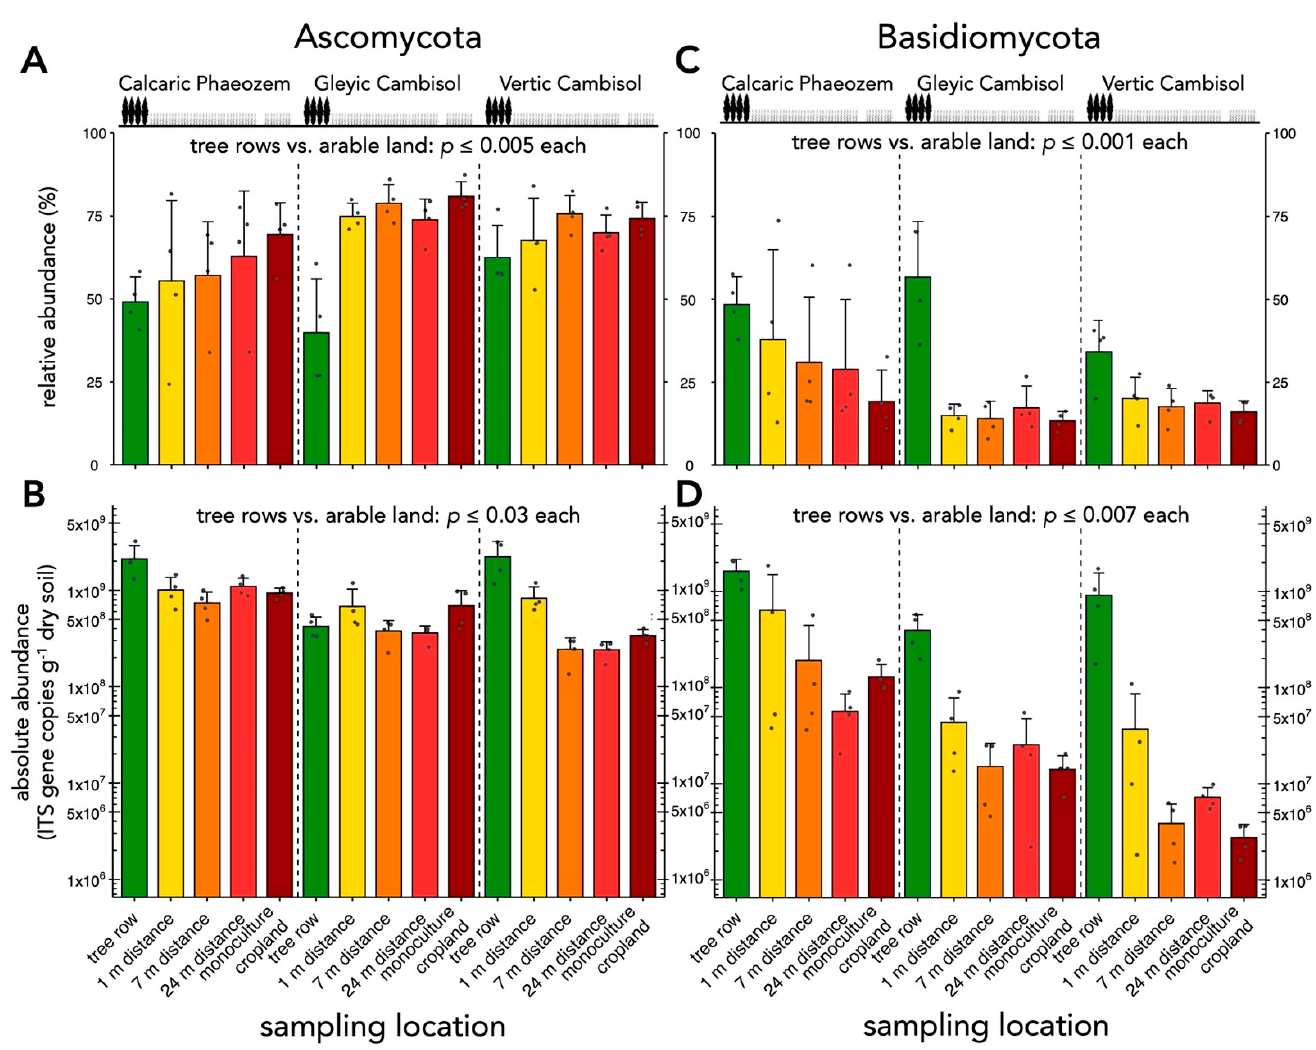
Figure 6. Abundance of Asco- and Basidiomycota. ( A ) Relative and ( B ) absolute abundance of Ascomycota. ( C ) Relative and ( D ) absolute abundance of Basidiomycota. Relative abundances were calculated from ASV counts obtained by amplicon sequencing. The absolute abundance, expressed as gene copy number, was determined by real-time polymerase chain reaction (PCR). Differences between sampling locations (tree row, 1 m, 7 m, and 24 m distance from the tree row within the crop row and monoculture cropland) were tested using linear mixed effect models with sampling location as fixed effect and site as random effect. Only differences between tree rows and arable land (1 m, 7 m, and 24 m distance from the tree row within the crop row and monoculture cropland) are reported in the panels. Bars represent the mean and error bars show standard deviation ( n = 4). Grey dots represent individual data